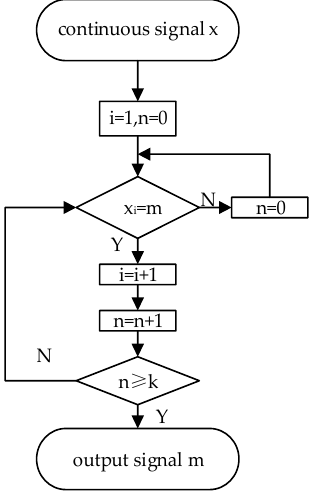
Figure 5. The flow of fault information conversion.